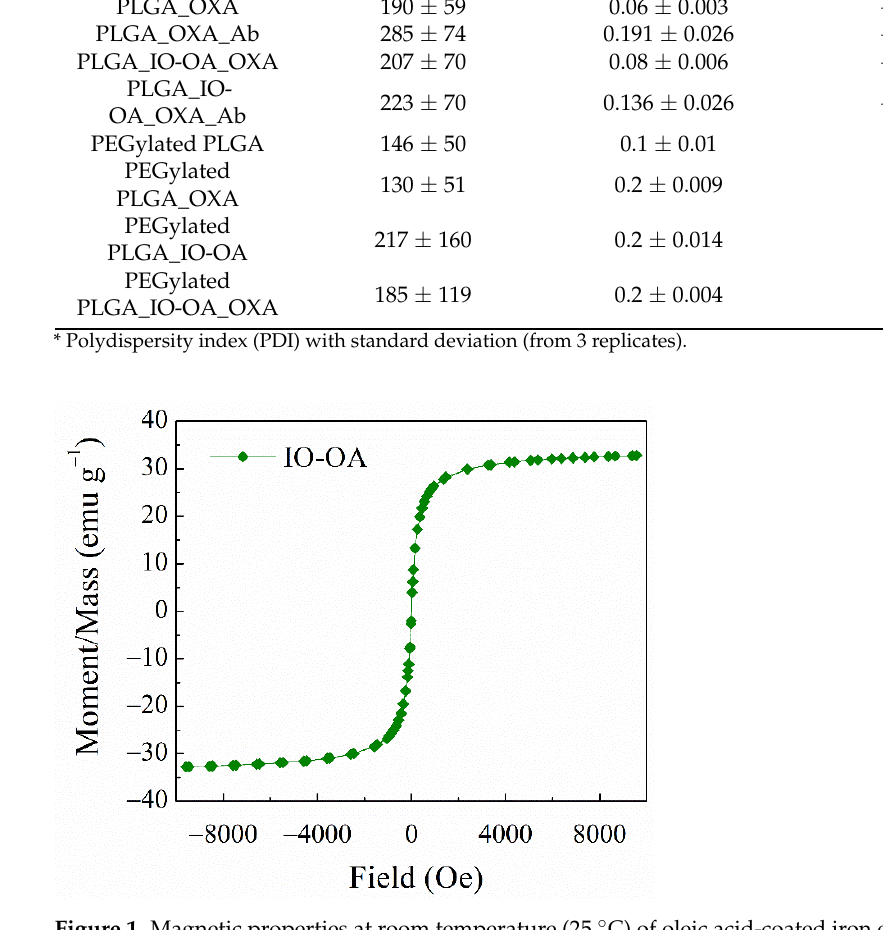
Figure 1. Magnetic properties at room temperature (25 °C) of oleic acid-coated iron oxide nanoparticles (IO-OA) synthesized by co-precipitation. The measurement was performed in the magnetic field from − 10 kOe to +10 kOe.